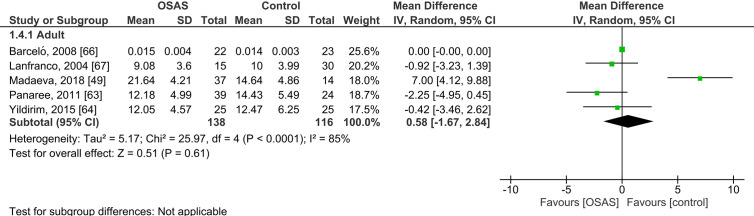
Forest plot of random-effects analysis of serum cortisol levels in adult obstructive sleep apnea syndrome (OSAS) versus the control group. The diamond shape indicates the pooled mean difference (MD). Each black box represents a point estimate of each study and also gives a representation of the study size (the bigger the box, the more participants in the study). A horizontal line representing the 95% confidence intervals (CIs) of the study result, with each end of the line representing the boundaries of CI. SD, Standard deviation.